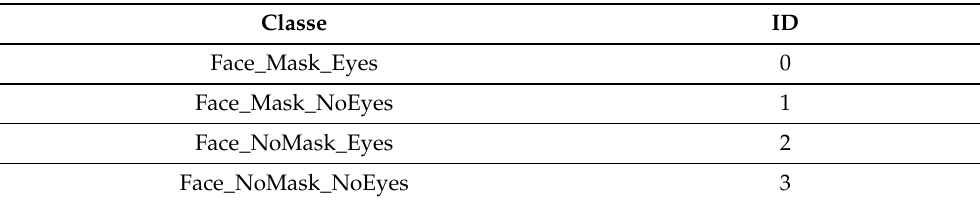
Table 3. Classes to be identified and their IDs, in the masks and goggles detection task, in the thermography